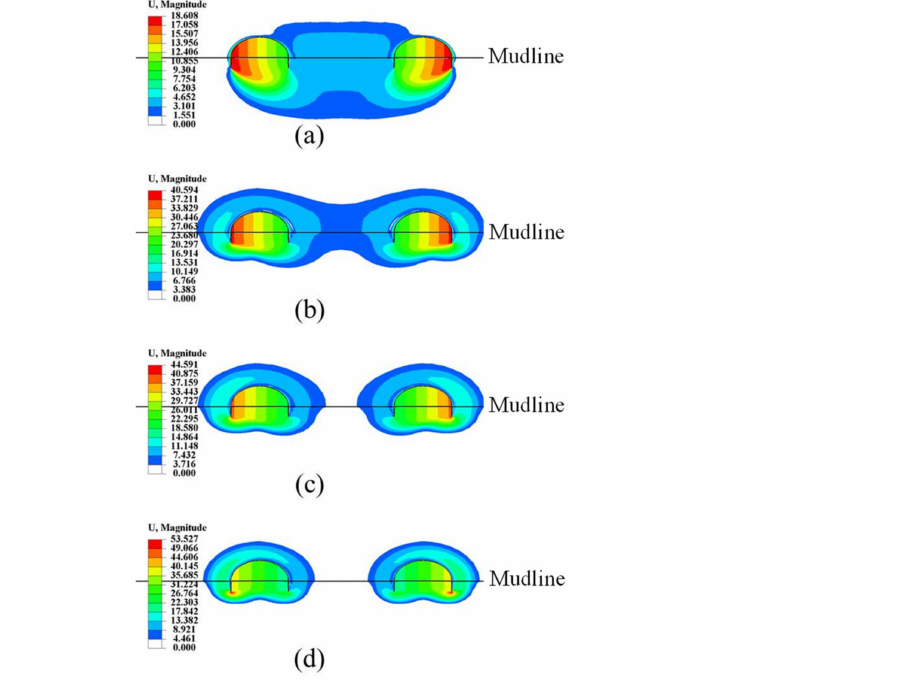
Figure 20. The magnitude of displacement contours of tetrapod bucket foundations and soils under ultimate moment loading at s/D = 2.0 and d/D = 0.25 when ( a ) κ = 0, ( b ) κ = 1, ( c ) κ = 2 and ( d ) κ =